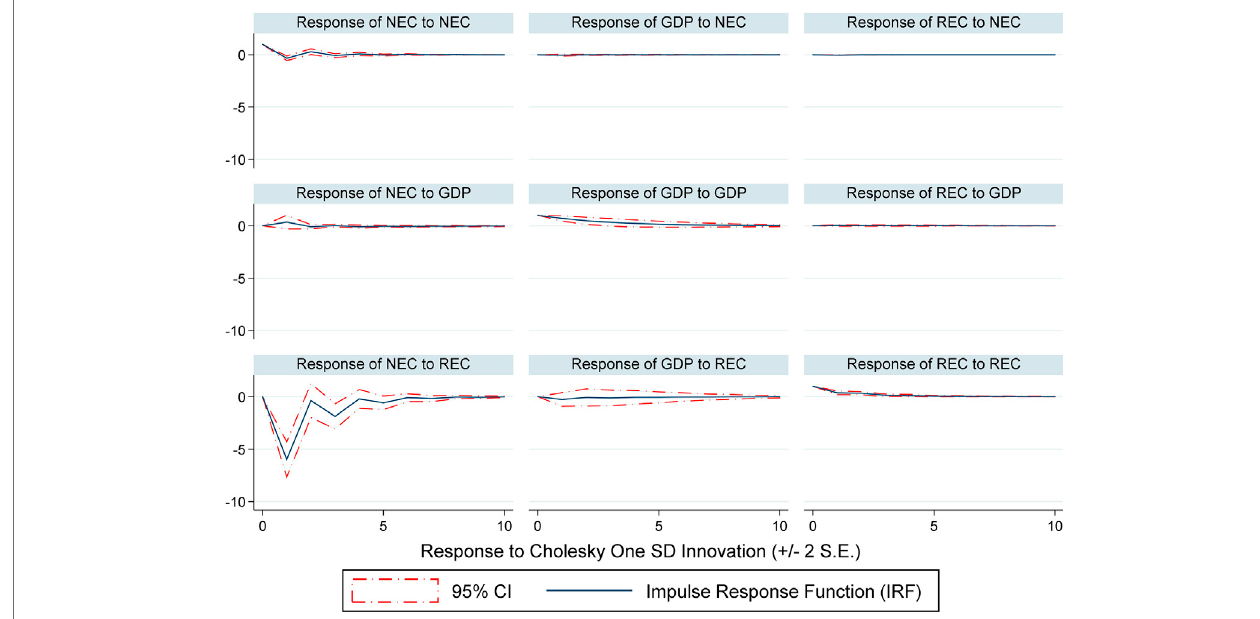
FIGURE 4 | Impulse Response Functions for Spain. Source: our elaboration.